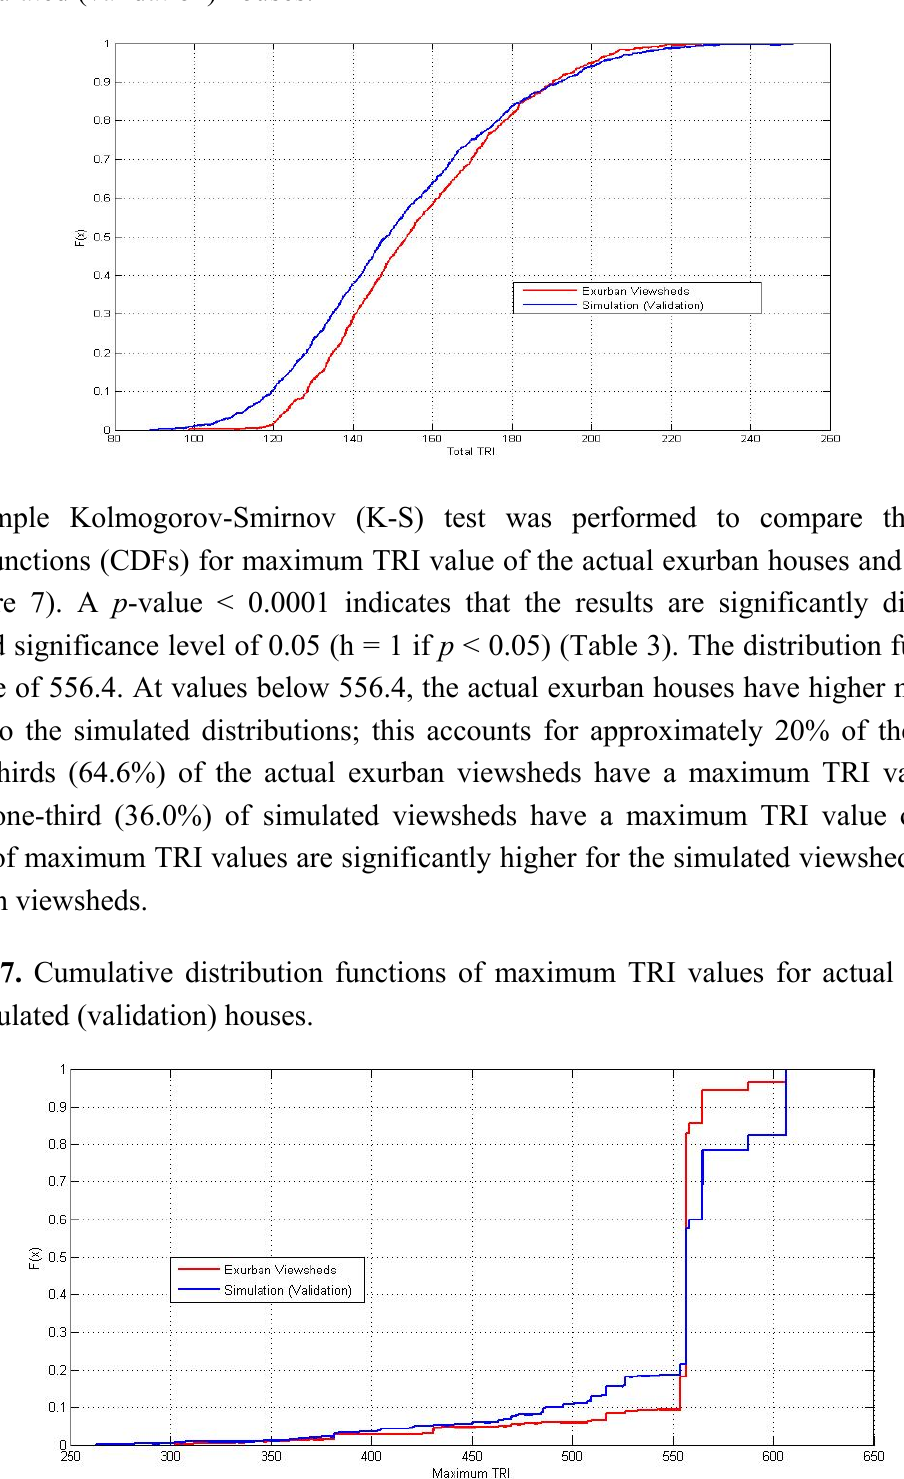
Figure 6. Cumulative distribution functions of total (mean) TRI values for actual exurban and simulated (validation) houses.